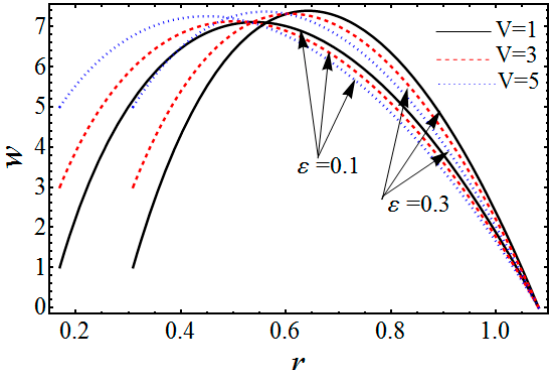
Figure 6. Variation of pressure rise ∆ p with ε and Br for fixed θ = 0.8, ϕ = 0.1, δ = 0.1, Gr = 0.2, Nb = 0.5, Nt = 0.2, λ 1 = 5, V = 0.1, t = 0.05.